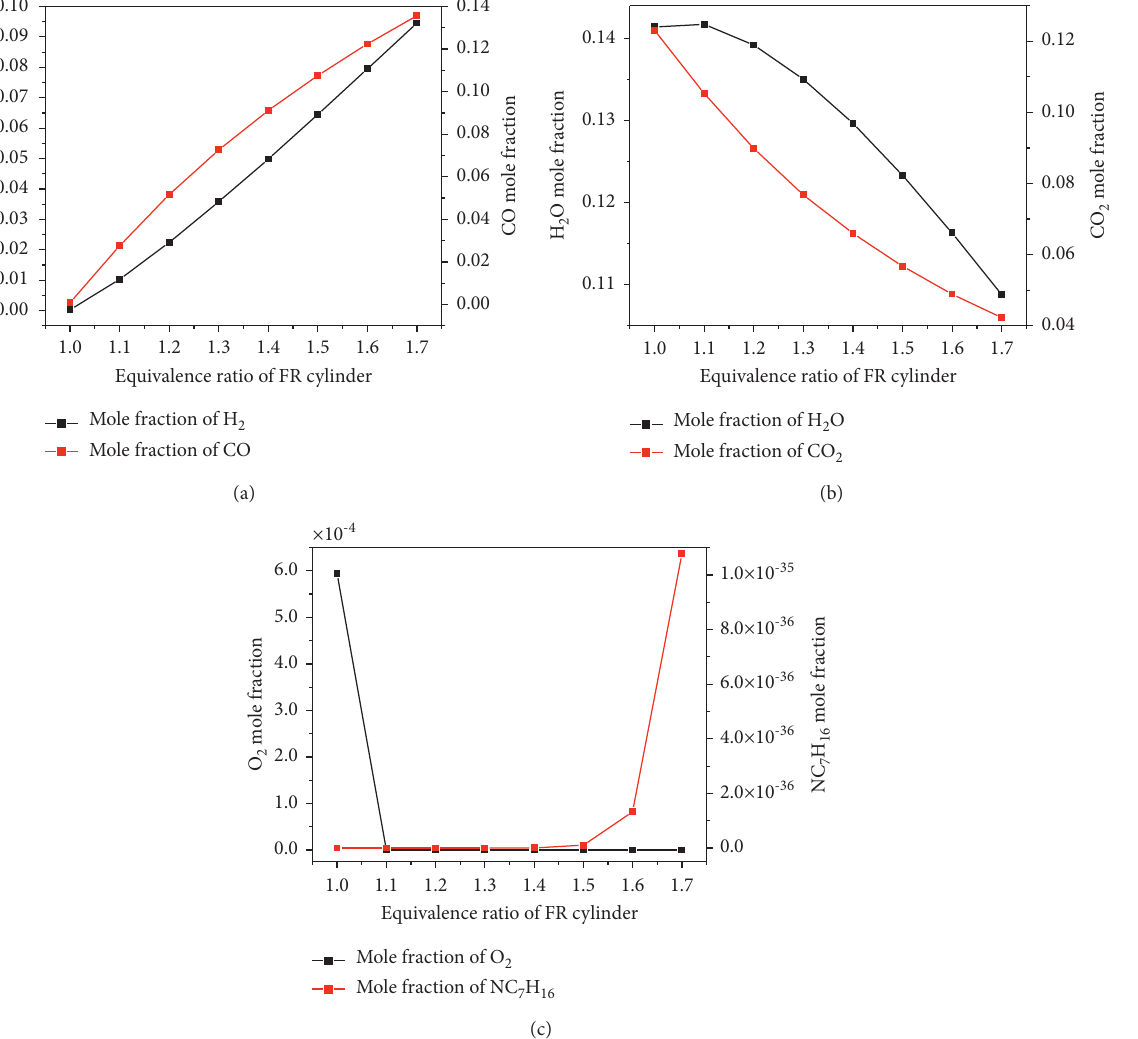
Figure 4: Mole fractions of H